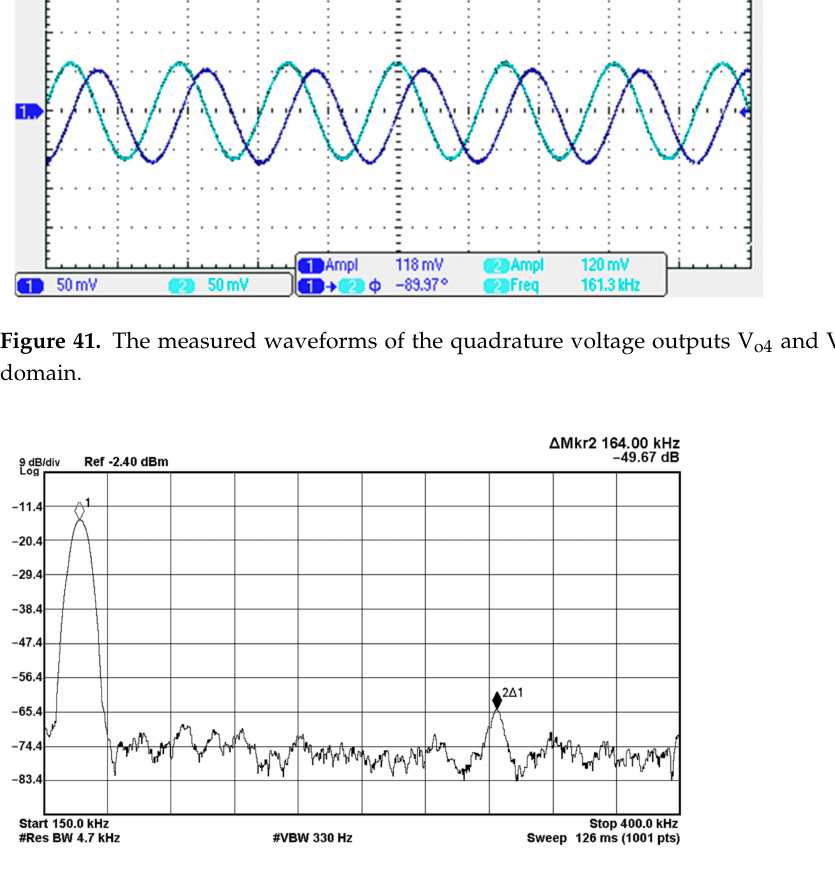
Figure 42. The frequency spectrum results of the VM fully uncoupled QSO at the V o5 output